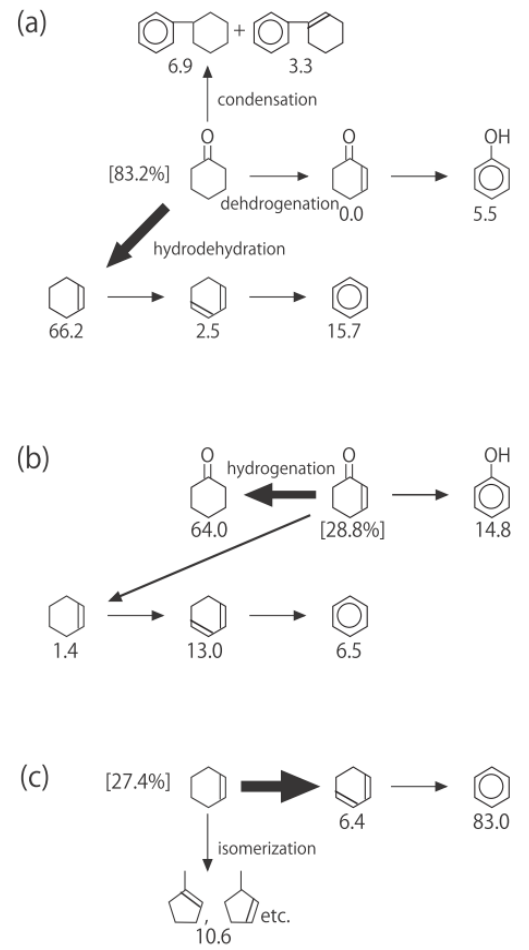
Figure 7. Reaction scheme of ( a ) cyclohexanone; ( b ) 2-cyclohexen-1-one; and ( c ) cyclohexene over (H O) [(Mo Cl )Cl ]·6H O/SiO in a hydrogen stream at 400 °C at 4–5 h after 3 2 6 8 6 2 2